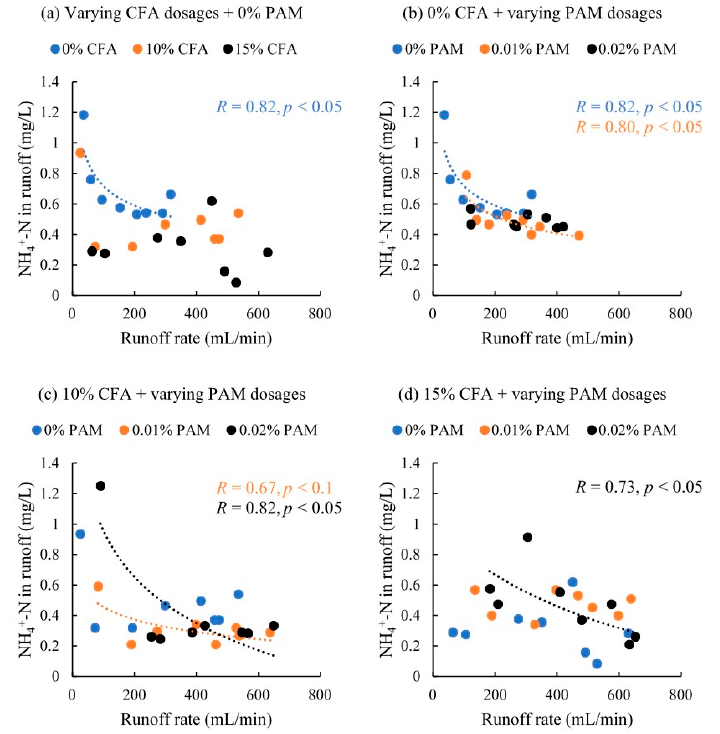
Figure 5. Correlation between NH 4+ -N concentrations in runoff and runoff rate for varying CFA dosages + 0% PAM ( a ), 0% CFA + varying PAM dosages ( b ), 10% CFA + varying PAM dosages ( c ), 15% CFA + varying PAM dosages ( d ).